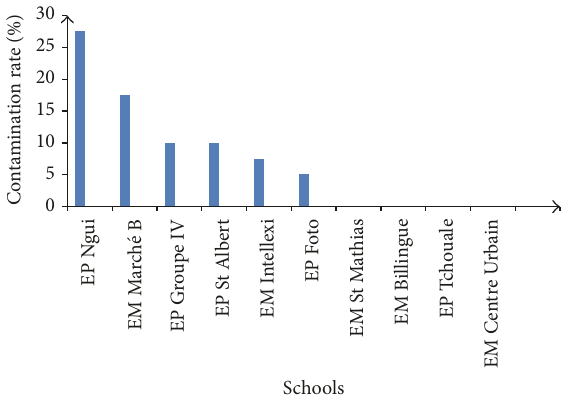
Figure 2: Percentages of soil contamination in different